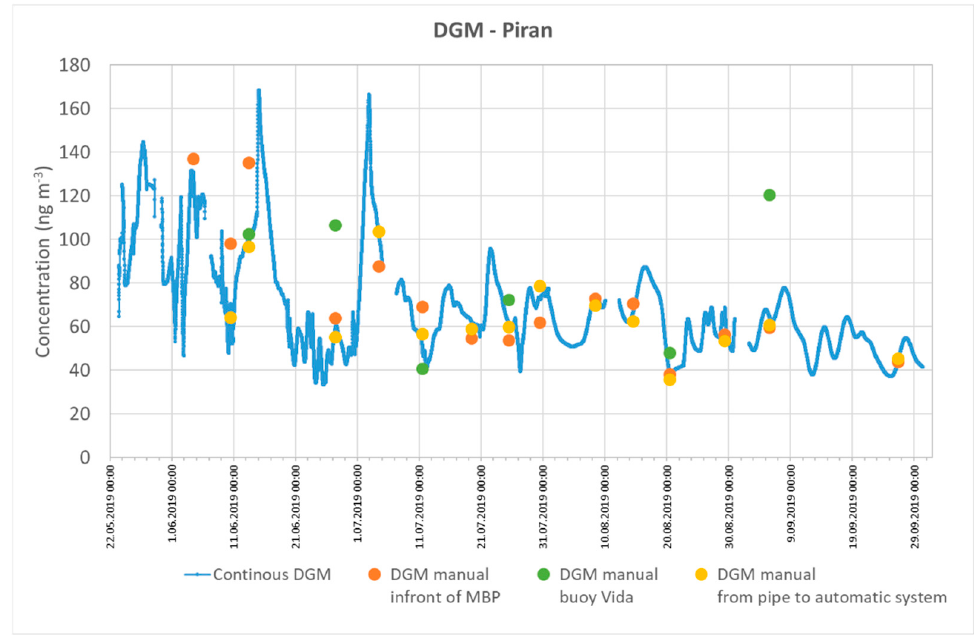
Figure 2. Comparison of continuous DGM measurements to discrete measurements at locations in front of the MBP, buoy Vida, and from pipe to continuous DGM measurement system.